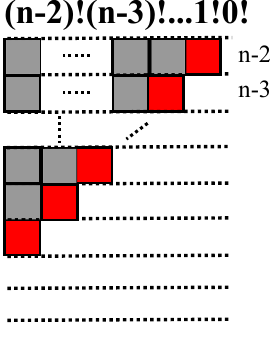
Figure 5 . The tableaux a